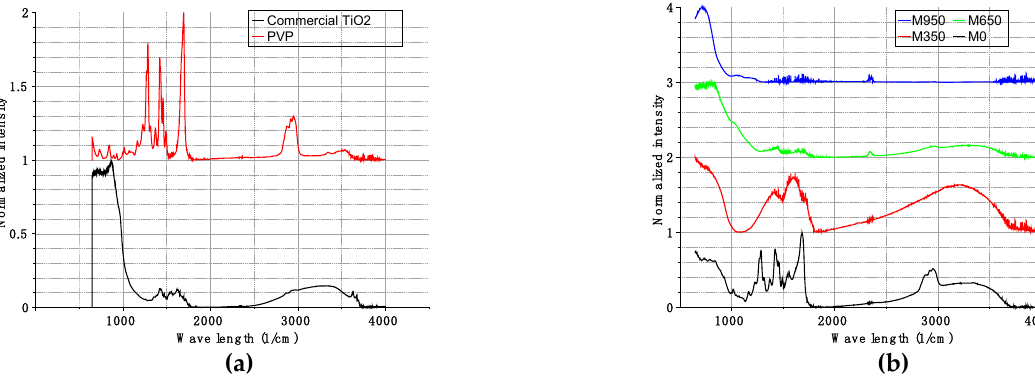
Figure 2. FTIR peak information for the ( a ) raw material, namely TiO 2 and PVP, ( b ) as-spun fiber after calcination. (The number after the M stands for the soaking temperature with unit ◦